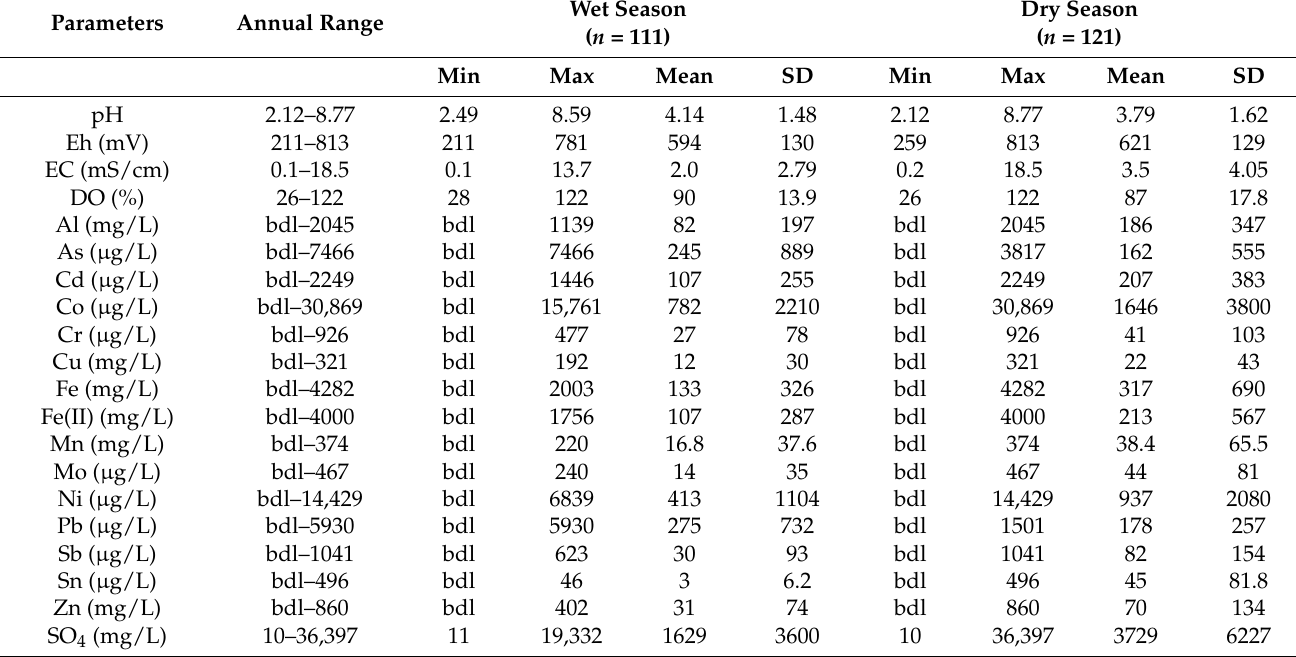
Table 1. Statistical summary of the parameters analyzed at 37 sampling points in the Odiel River Basin.